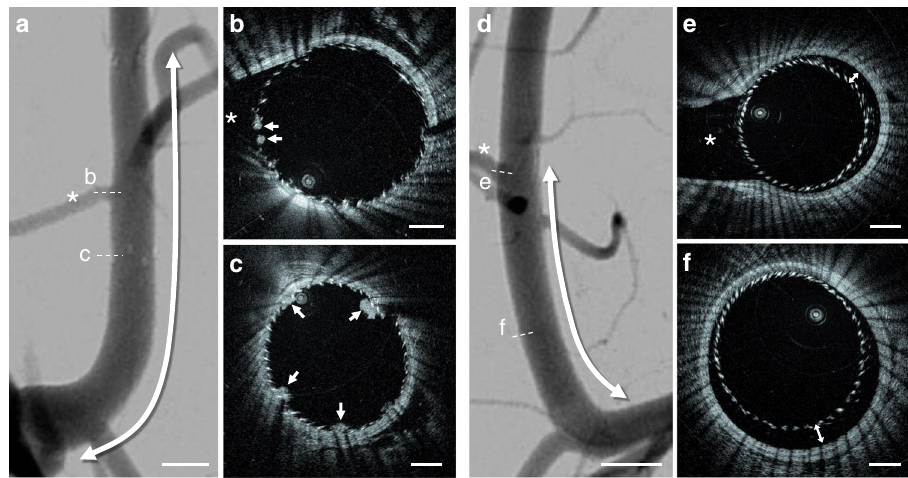
Fig. 4 HF-OCT imaging comparison with DSA. a Digital subtraction angiography (DSA) of an internal maxillary artery stented using fl ow-diverting and neurovascular stents. The stented segment is indicated by the arrow, with the devices partially overlapping. Corresponding HF-OCT images show thrombus formations (arrows) not observed on fl uoroscopy located over the struts of the fl ow-diverter at the level of a side branch b , and over the struts of the fl ow-diverter and intra-cranial stent in the overlapping segment c . d DSA of a second IMAX artery treated with a fl ow-diverting stent. The corresponding HF-OCT cross-sectional images depict device malapposition at different locations not seen on DSA, with maximum extensions of ~0.35 mm e and 0.45mm f . HF-OCT comparison with DSA was repeated for all swine internal maxillary arteries ( n = 16), following fl ow-diverting ( n = 16), and self- expanding intracranial stent implantation ( n = 15). Scale bars on DSA images are equal to 5.0 mm; HF-OCT scale bars to 1.0 mm.